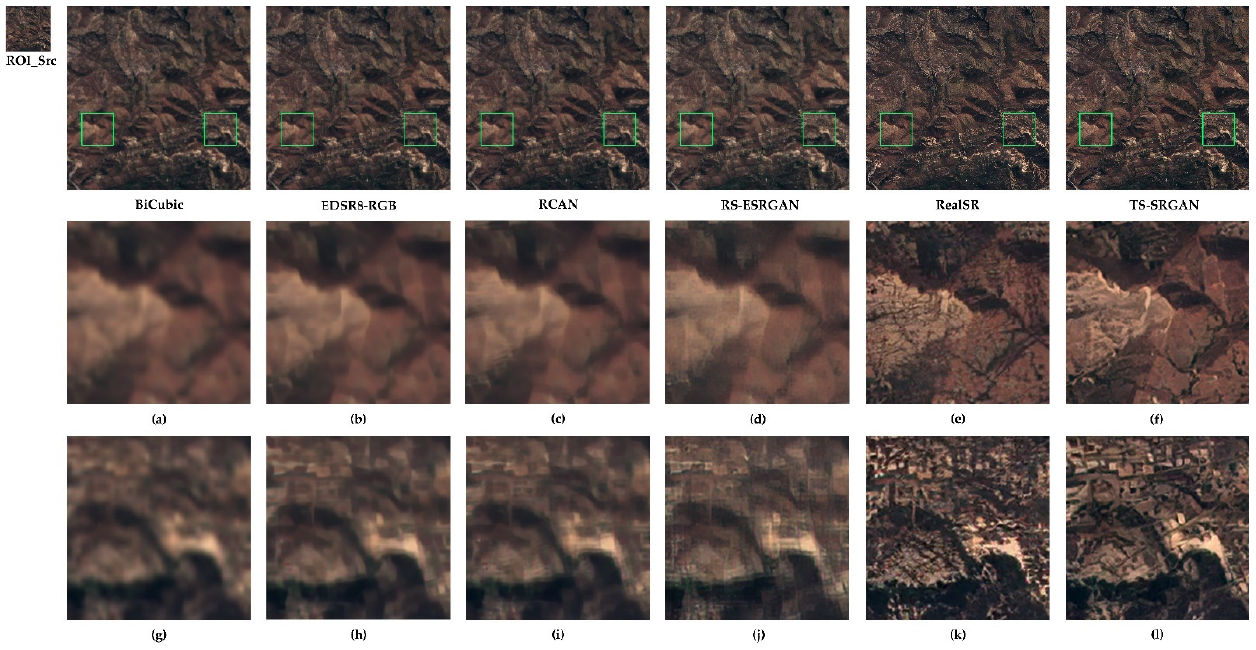
Figure 15. Comparison of visual effects of the generated images of the region with hilly terrain. NR-IQA of images (NIQE, BRISQUE, PIQE): BiCubic (6.35, 58.38, 92.36), EDSR8-RGB (5.88, 48.02, 81.31), RCAN (4.62, 46.94, 52.83), RS-ESRGAN (3.99, 27.62, 7.61), RealSR (2.83, 13.25, 7.84), TS-SRGAN (2.74, 3.83, 15.57). The subfigures ( a – l ) in the figure represent an enlarged view of the local details in the green boxes in the generated image.